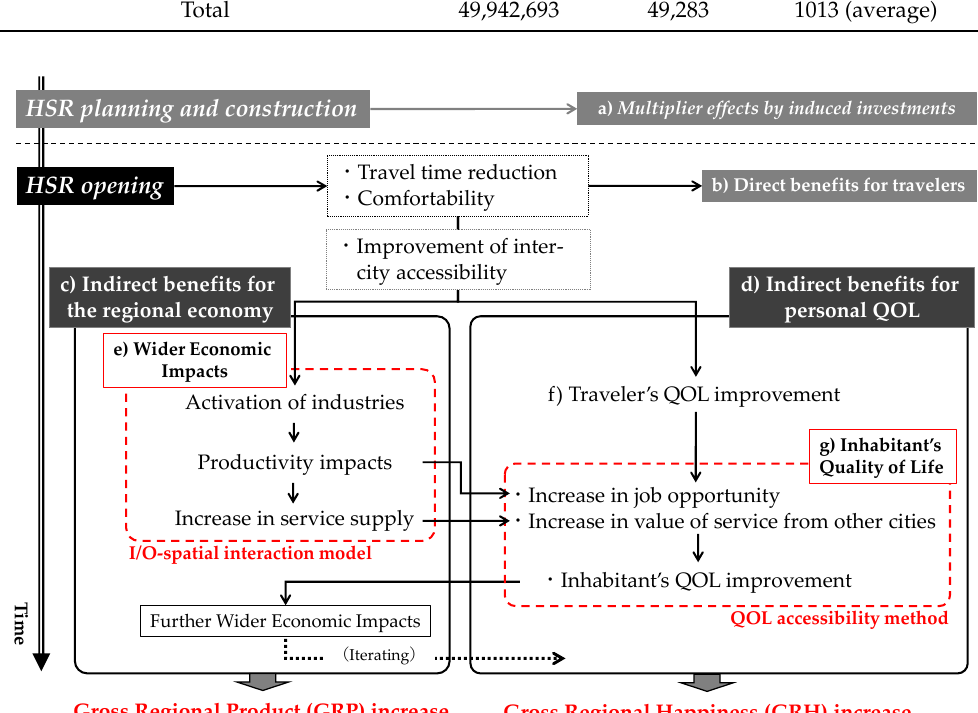
Figure 2. Mechanism and model system of HSR benefits.